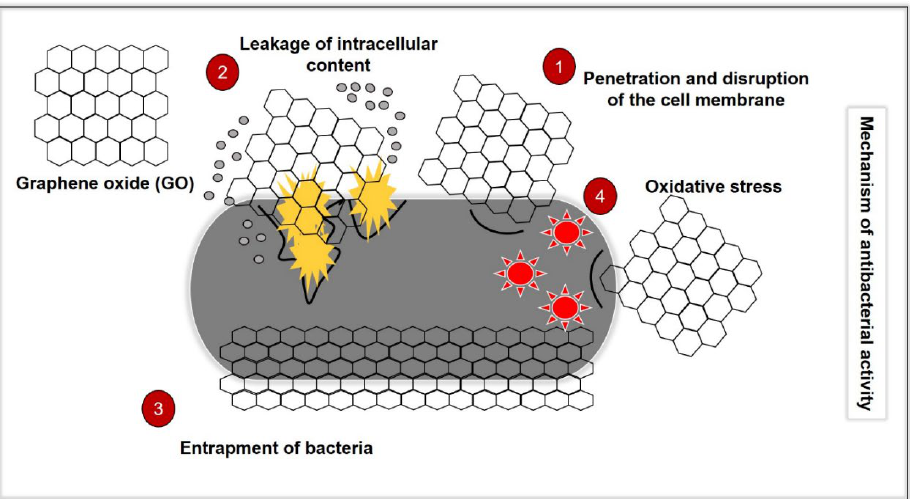
Figure 2. Illustration of the antibacterial mechanisms of GO, which consist of (1) penetration and disruption of the bacterial cell membrane, (2) leakage of the intracellular content following penetration and disruption of the cell membrane, (3) oxidative stress by the generation of reactive oxygen species (ROS0 and depletion of the antioxidant in the bacteria) and (4) bacteria entrapping (wrapping effect) by GO.